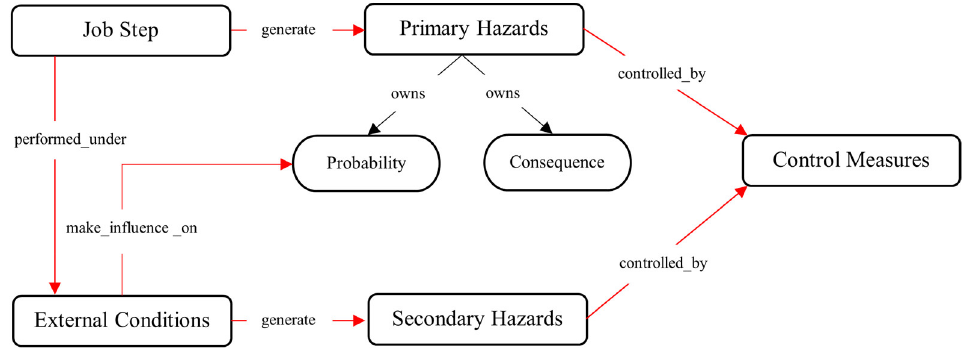
Figure 3. High-level concepts and links of O-JHAKG.